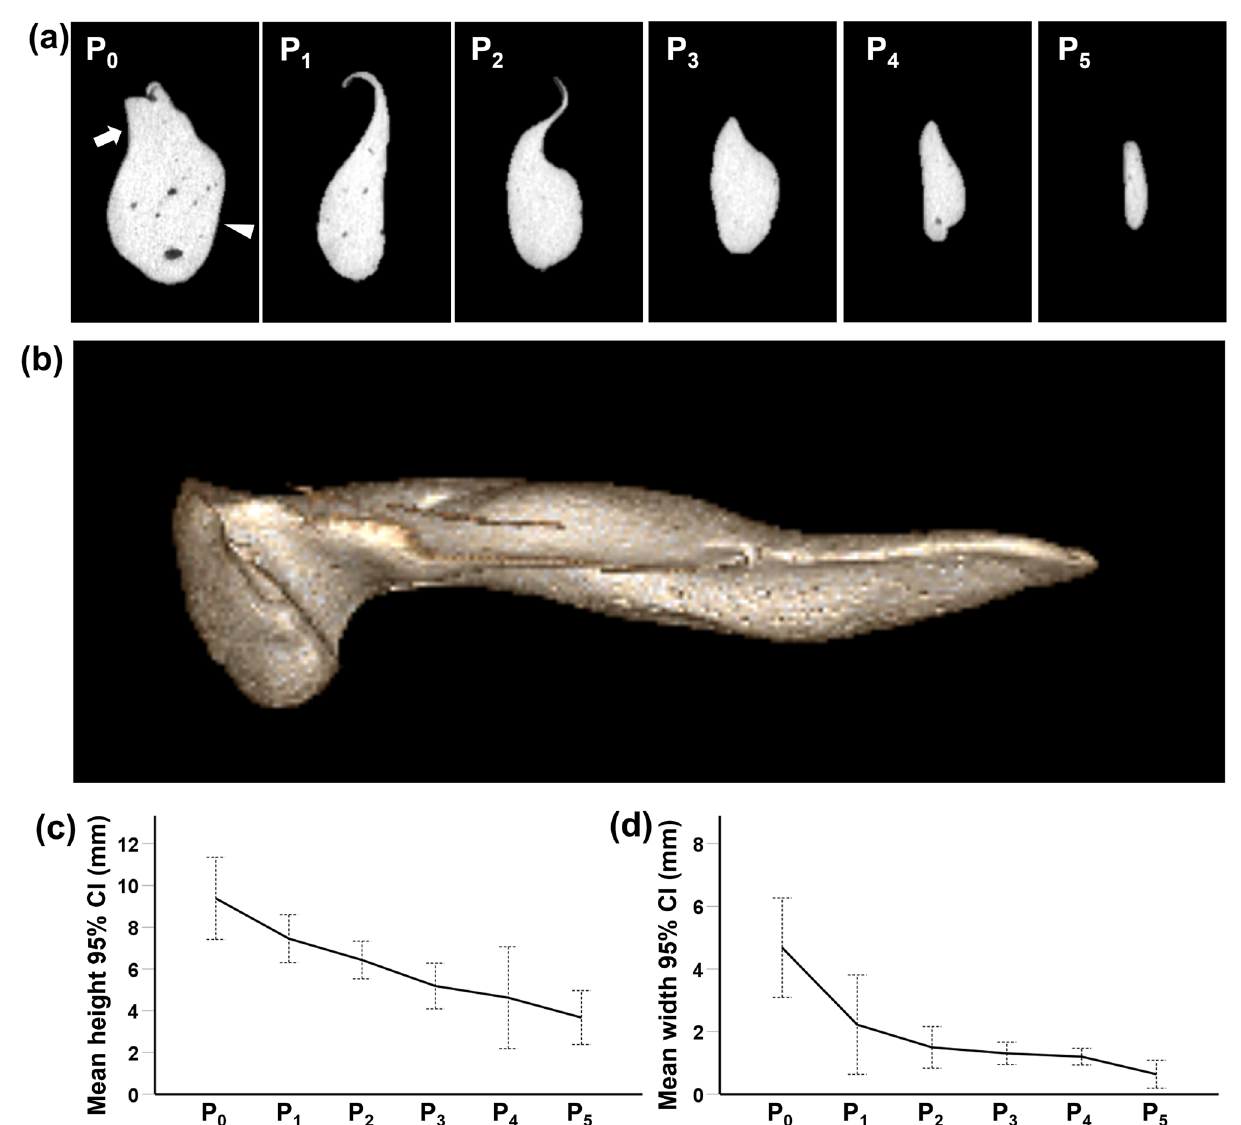
Rüdinger safety canal ( arrow ) and the auxiliary gap ( arrowhead ). ( b ) 3D-reconstructed CT images of the porcine ET phantom showing a posterolateral curvature until midpoint, followed by a curved anterior wall. The ( c ) height and ( d ) width of the axially sectioned porcine ET phantom gradually decreased from the nasopharyngeal ostium to the